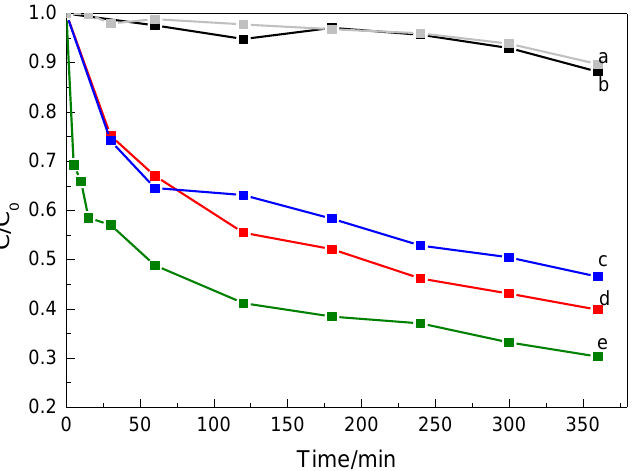
Figure 4. Photocatalytic degradation of RhB by different photocatalysts: none ( a ), BTO ( b ), BTO_1 ( c ), BTO_2 ( d ), and BTO_3 ( e ).